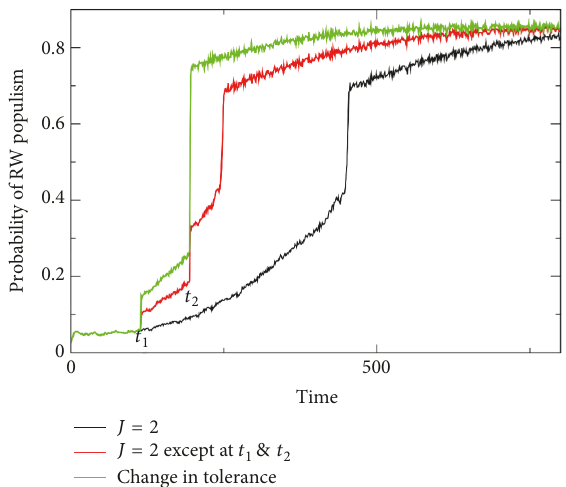
Figure 5: Breakdown of the causes of right-wing populism . Figure 4 Figure 4: Nonlinearity, a tipping point, and the rise of right-wing shows that the probability of RW populism, 𝑃 , suddenly increases populism. Using a network of 𝑁 = 5,000 agents, each with an as society approaches a tipping point but remains silent on the average of 15 connections, we examine the effect of a constant underlying causes. Here we discern between the contributions inflow of outsiders at rate 𝐽 = 2 at each time step. In this setup, of local outsider influence (assumption (ii)) and mutual insider the total number of outsiders at any moment in time is 𝐼(𝑡) = contagion (assumption (iii)). Far from the tipping point, 𝑃 mainly ∑ 𝐽 = ⟨𝐽⟩𝑡 . As the fraction of outsiders, 𝑓 = 𝐼/(𝑁 + 𝐼) , 𝑖 𝐼 𝑖 responds to local outsider influence (ii). By contrast, as the network approaches the tolerance parameter, 𝑓 󸀠 𝐼 = 0.15 , the presence of a approaches its tipping point, mutual insider contagion (iii) takes tipping point causes the fraction of RW populist supporters to start over and accelerates the transition to RW populist dominance. increasing nonlinearly and eventually undergo a sudden jump (i.e., Parameter values are 𝑁 = 5,000 with an average degree of 15, 𝐽 = 2 , a discontinuous change) at about 37 years (450 months) into the 𝑝 = 0.007 , 𝜏 = 15 , 𝑝 󸀠 = 0.7 , and 𝑝 󸀠󸀠 = 0.8 simulation (black curve). The sudden jump happens much earlier if the inflow of outsiders experiences shocks at times 𝑡 1 and 𝑡 2 at which 𝐽 = 200 outsiders enter the network. In particular, as the network approaches the tipping point, the effect of exactly the same shock becomes disproportionately higher (red curve). In this case, however, the tolerance parameter is still kept constant. Finally, we also examine the case in which shocks at times 𝑡 1 and 𝑡 2 affect the tolerance parameter, where responsiveness is controlled by parameter 𝛾 = 0.0001 . Here, the second shock at 𝑡 2 is sufficient to instantly tip the network into RW populism (green curve). Other parameters are 𝑝 = 0.007 , 𝜏 = 15 , 𝑝 󸀠 = 0.5 , 𝑝 󸀠󸀠 = 0.5 , and 𝛼 = 0.001 .